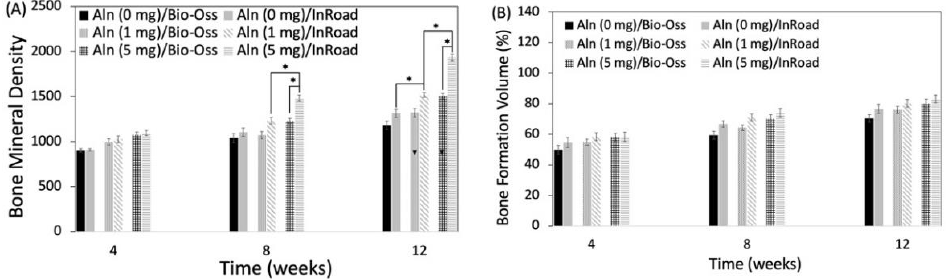
Figure 7. ( A ) Bone mineral density and ( B ) bone formation volume (%) at 4, 8, and 12 weeks after implantation. The error bars represent mean ± SD (n = 5). (* p < 0.05).